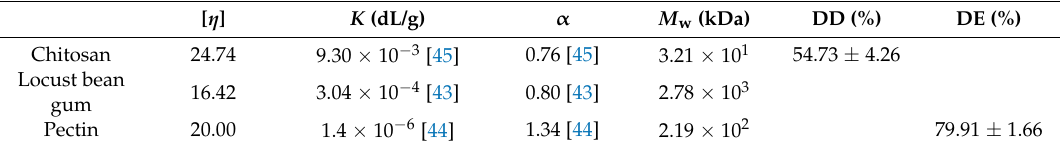
Figure 1. Plots of reduced viscosity, η sp /c (dL/g) vs. concentration (g/dL) for polymeric gels of chitosan, locust bean gum and pectin. Table 2. Results obtained from the characterization of the polymers employed.